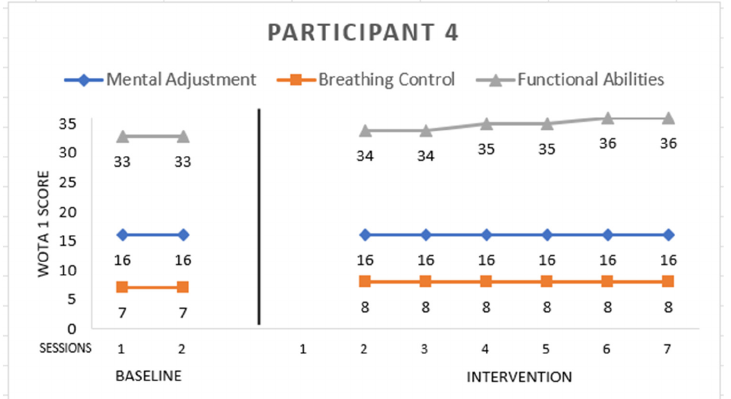
Figure 4. Highest possible scores: Mental Adjustment = 16, Breathing Control = 8, Functional Abilities = 36.